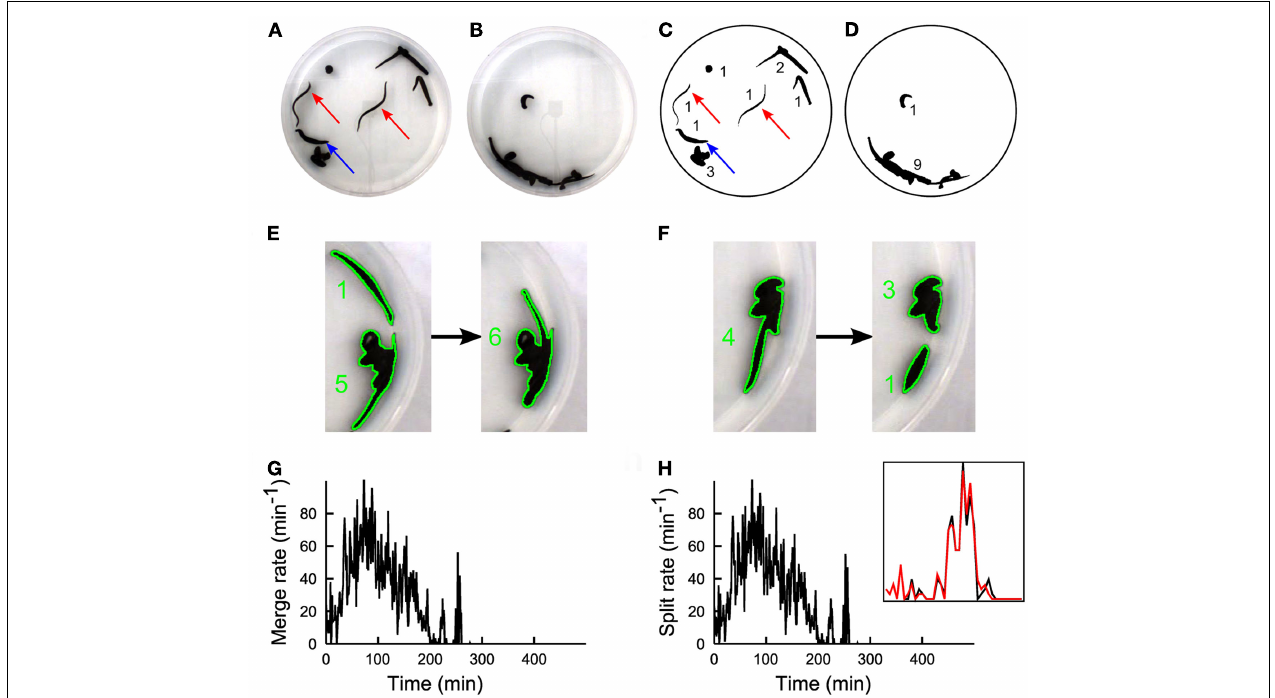
group formation, two kinds of events occurred: two groups could merge (E) forming a larger group, or a single group could split (F) forming two groups. During the searching phase, merge (G) , and split (H) rates have similar values, because leeches are highly active and no formation of stable groups can be observed. Inset in panel h shows a zoom of Merge (black) and Split(red) on an enlarged scale. Merge and split plots are very similar because they are evaluated on a sliding time window of size 5min. Subtle differences between these two signals determine the group formation dynamics.